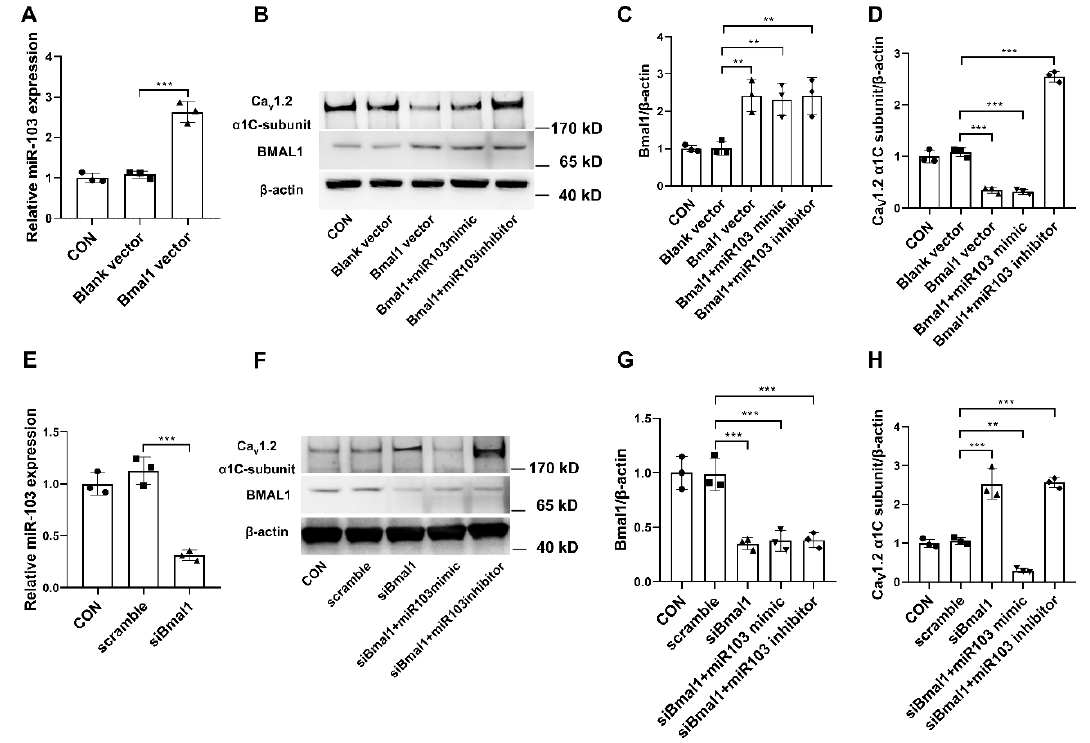
Figure 6. BMAL1 modulates the protein expression of Ca V 1.2 α 1C-subunit by miRNA-103 signal pathway. ( A ) The mRNA levels of miR-103 in A7r5 cells transfected with BMAL1 overexpression plasmid. The representative protein expressions of Ca V 1.2 α 1C-subunit and BMAL1 ( B ) and the mean data ( C , D ) with the treatment of miR-103 mimic and inhibitor in A7r5 cells transfected with BMAL1 overexpression plasmid, respectively. ( E ) the mRNA levels of miR-103 in A7r5 cells transfected with BMAL1 siRNA. The representative protein expressions of Ca V 1.2 α 1C-subunit and BMAL1 ( F ) and the mean data ( G , H ) with the treatment of miR-103 mimic and inhibitor in A7r5 cells transfected with BMAL1 siRNA, respectively. Data are presented as box plots and 5th and 95th percentiles. Each experiment was repeated three times, one-way ANOVA and Tukey’s multiple comparisons test, ** p < 0.01, *** p < 0.001 as compared with the control (the full-length Western blots for Figure 6B,F are shown in the Supplementary